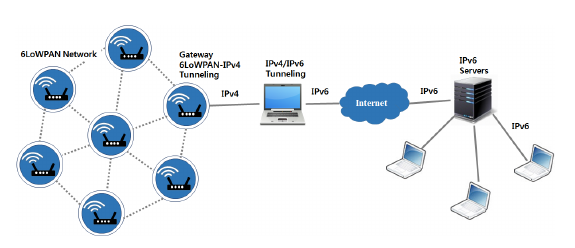
Figure 2. 6LoWPAN Network.